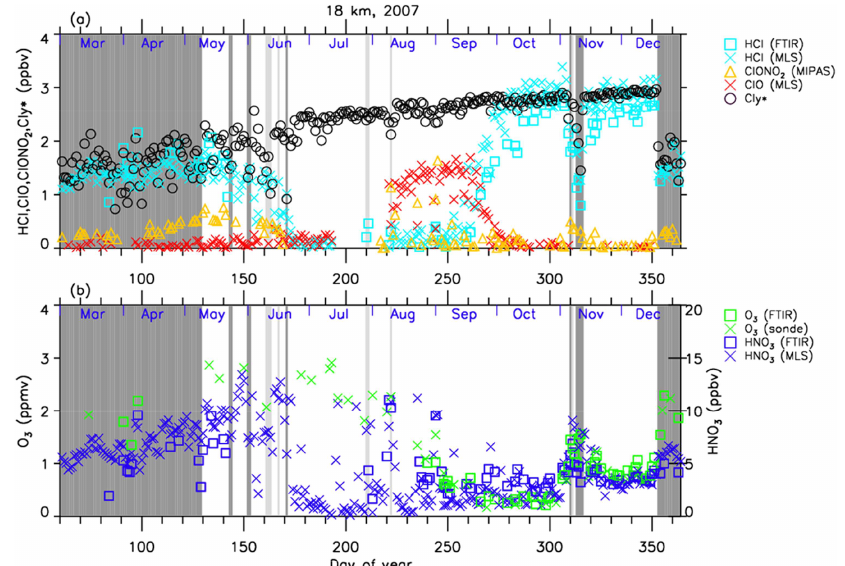
Figure 4. Time series of (a) HCl, ClONO 2 , ClO, and Cl ∗ y as well as (b) O 3 and and HNO 3 mixing ratios at 18km in 2007 over Syowa Station. O 3 (FTIR), HCl(FTIR), and HNO 3 (FTIR) were measured by FTIR at Syowa Station, while HCl(MLS), ClO(MLS), and HNO 3 (MLS) were measured by Aura MLS. O 3 (sonde) was measured by ozonesonde. ClONO 2 was measured by Envisat MIPAS. Cl ∗ y is calculated from the Aura MLS N 2 O value. See text in detail. The unit of O 3 is parts per million by volume (ppmv) and the other gases are parts per billion by volume (ppbv). The dark shaded area, the light shaded area, and the white area indicate the days when Syowa Station was located outside the polar vortex, in the boundary region of the polar vortex, and inside the polar vortex, respectively.